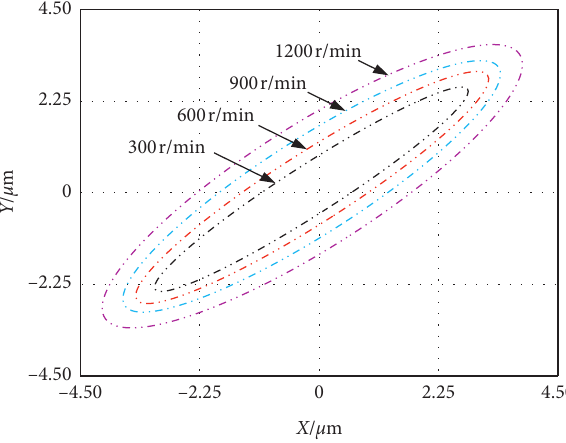
Figure 8: Change law of spindle rotation error at different speeds.